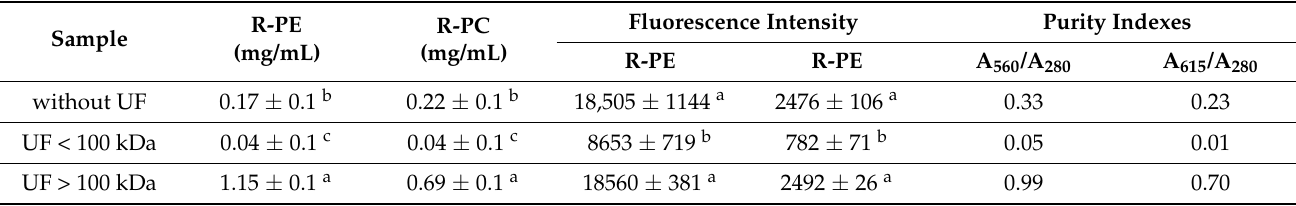
Table 2. Concentrations, fluorescence intensity and purity indexes of R-PE and R-PC before and after ultrafiltration (100 kDa) of supernatant of